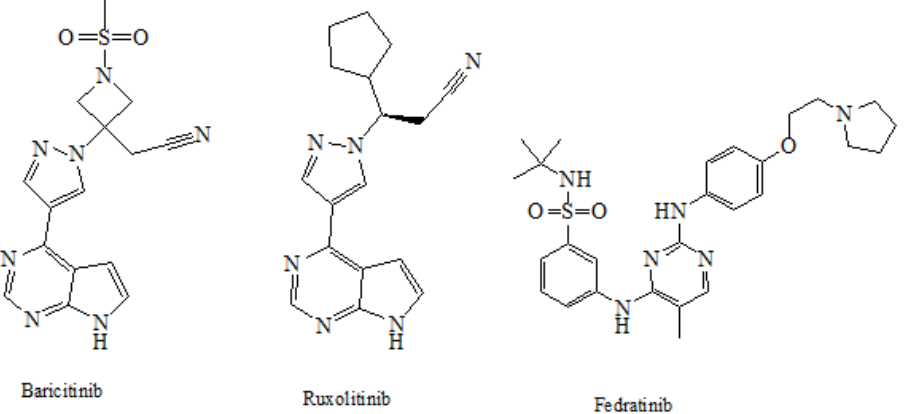
Figure 4. Structures of baricitinib, ruxolitinib, and fedratinib.